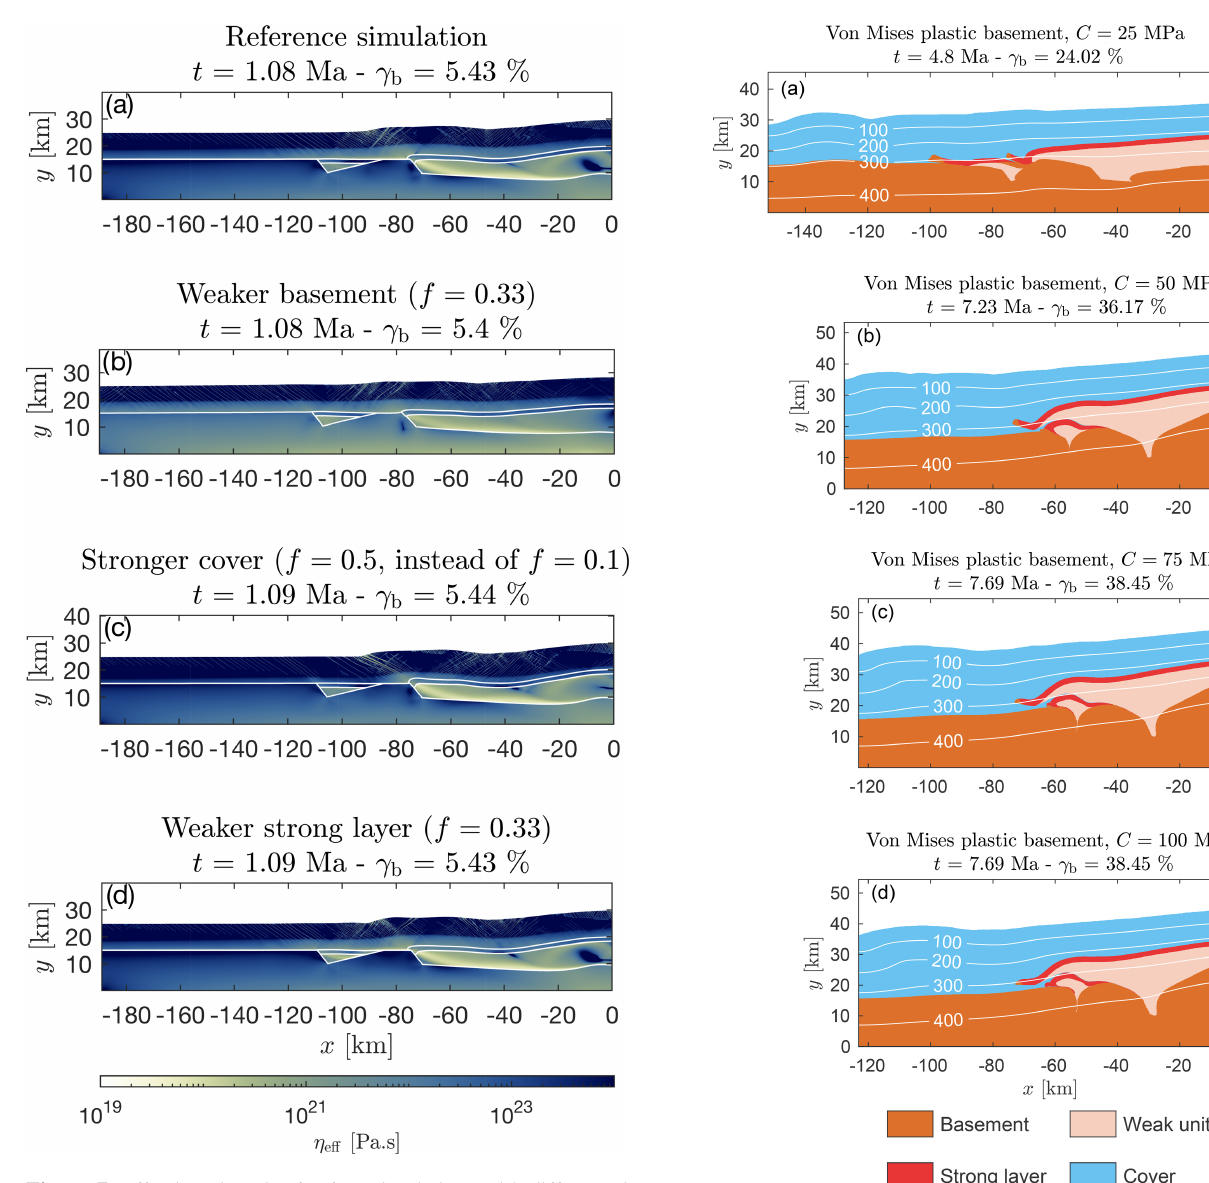
Figure 7. Effective viscosity for four simulations with different f factors for certain model units after a bulk shortening of approxi- mately 5.4%. Below the brittle–ductile transition, the effective vis- cosity (i.e., ratio of stress and viscoelastic strain rate) essentially equals the viscosity calculated from the dislocation creep flow law (Eq. 1). Panel (a) displays the reference simulation and panels (b–d) display the three simulations shown in Fig. 6.